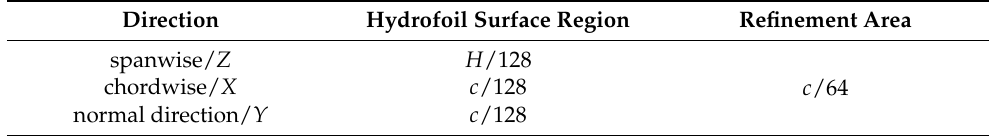
Table 2. Grid size and refinement scheme.